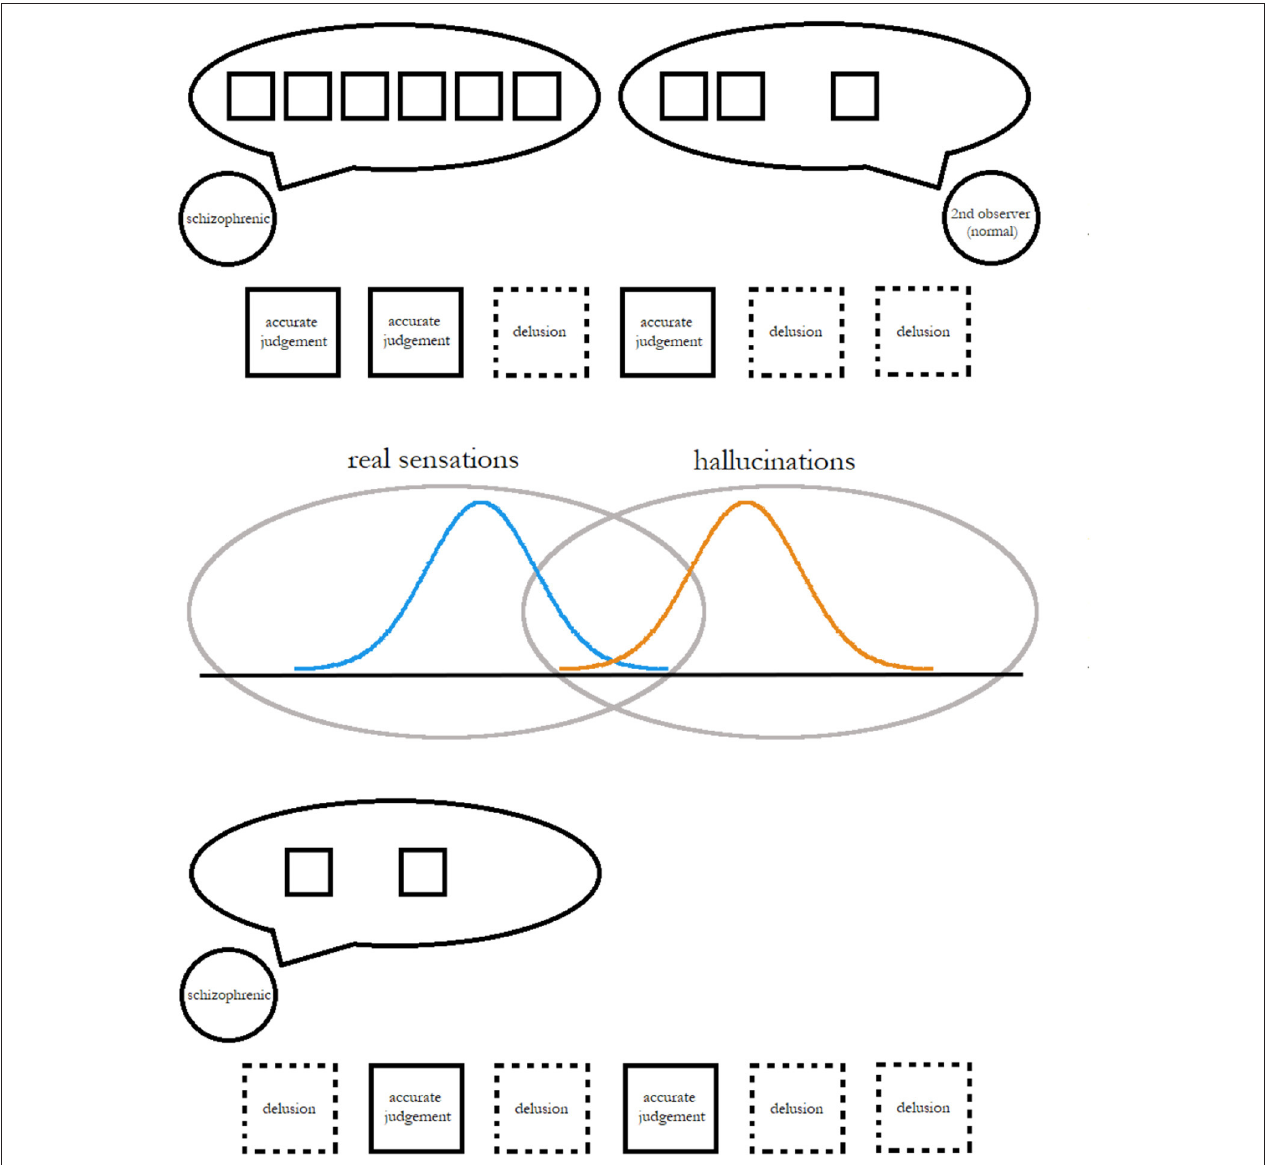
FIGURE 1 | A simplified depiction of a proposed scheme to measure and improve the effectiveness of individuals’ cognitive techniques for determining the reality of an observation.